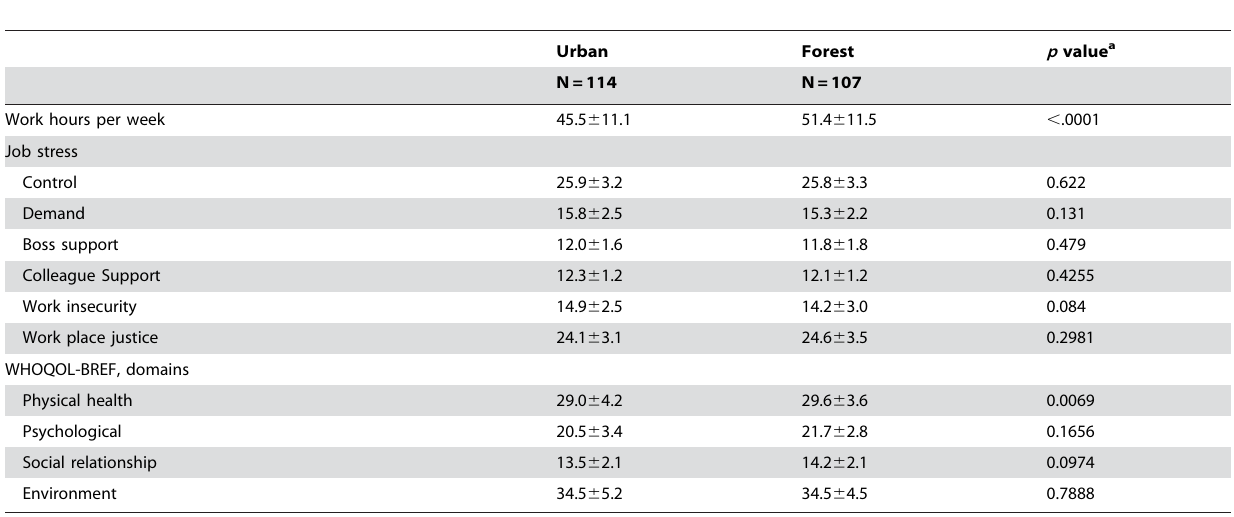
Table 3. Work hours, job stress scores (Job Content Questionnaires), and WHOQOL-BREF domain scores of urban and forest staff member groups.